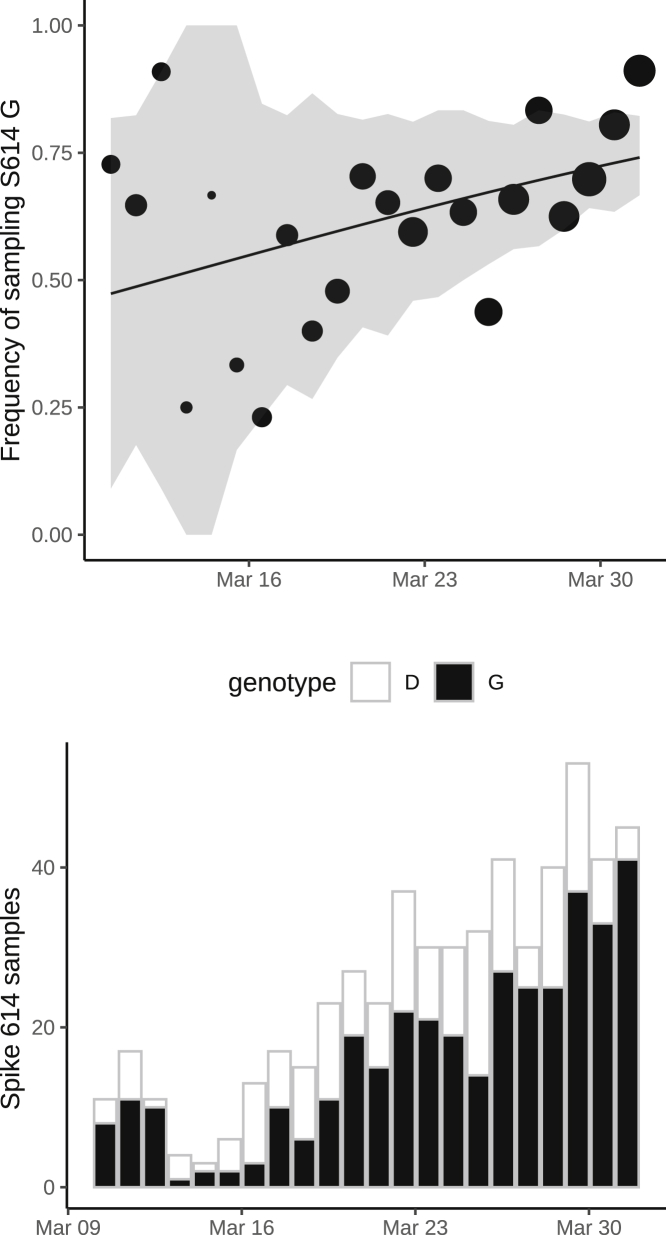
Frequency of Sampling Spike 614G over Time, Related to Figure 3This shows frequency and numbers of Spike 614G and Spike 614D samples over time. The size of points represents the number of samples collected on each day. The line and shaded region showed the MLE and confidence interval fit of the logistic growth model.